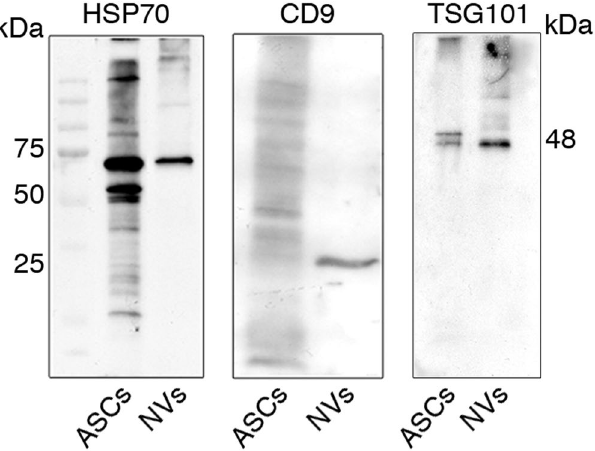
Figure 1. Characterization of ASC-NVs by western blot analysis. Protein lysates from ASC cells and ASC-NV fractions were separated on polyacrylamide gels and probed with specific NVs markers. In NV fractions, a single band at 70 kDa and around to 25 kDa was present after incubation with HSP70 and CD9 antibodies, respectively. Similarly, the treatment with anti-TSG101 antibody displayed an intense signal at 48 kDa in NV populations. Moreover, ASC cells expressed both HSP70 and TSG101 markers whereas showed weak reactivity against CD9